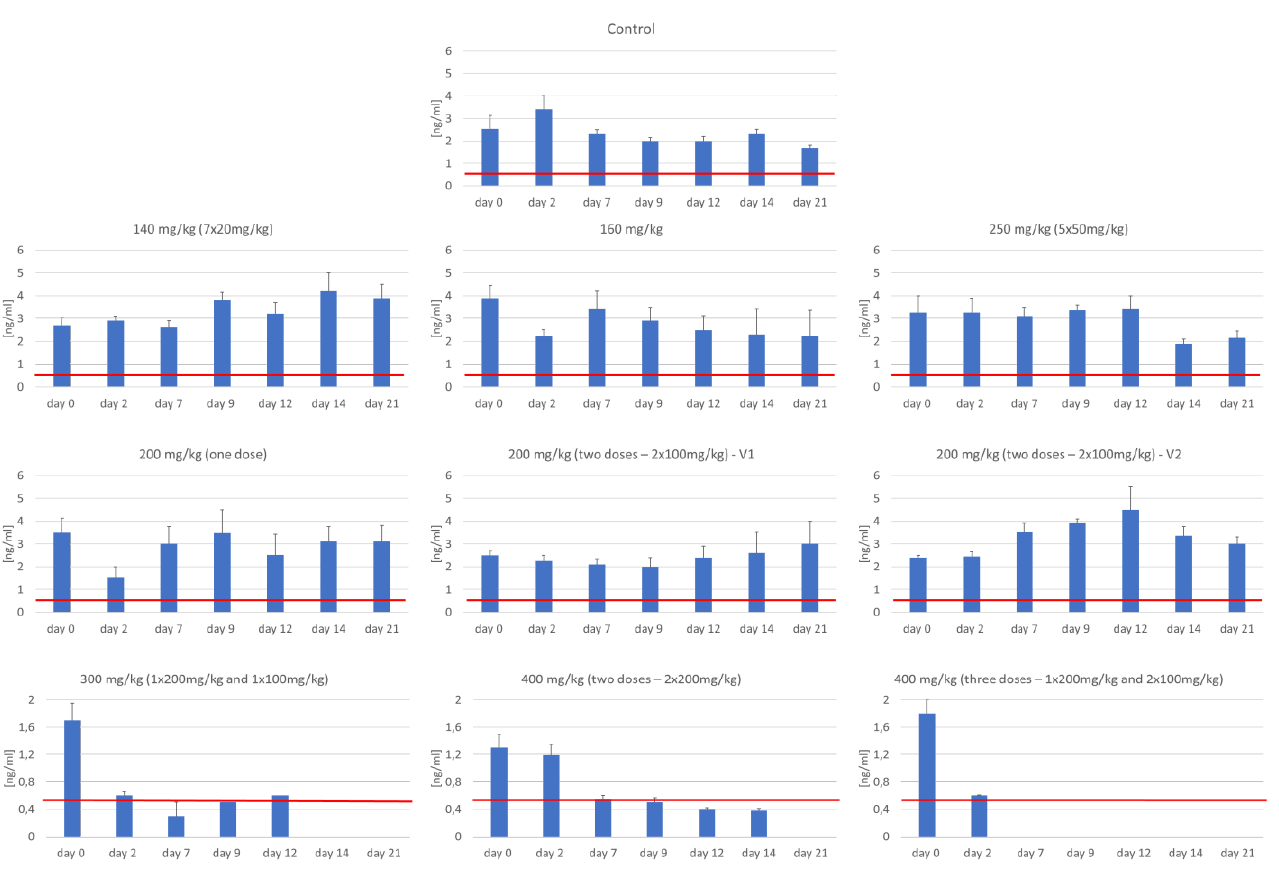
Figure 6. Level of C-peptide concentration.